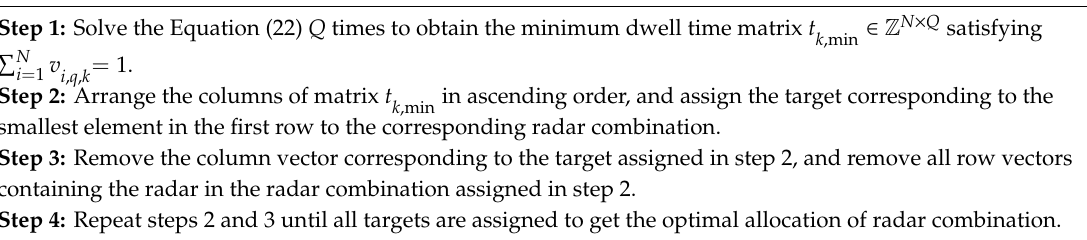
Algorithm 2 Radar allocation method